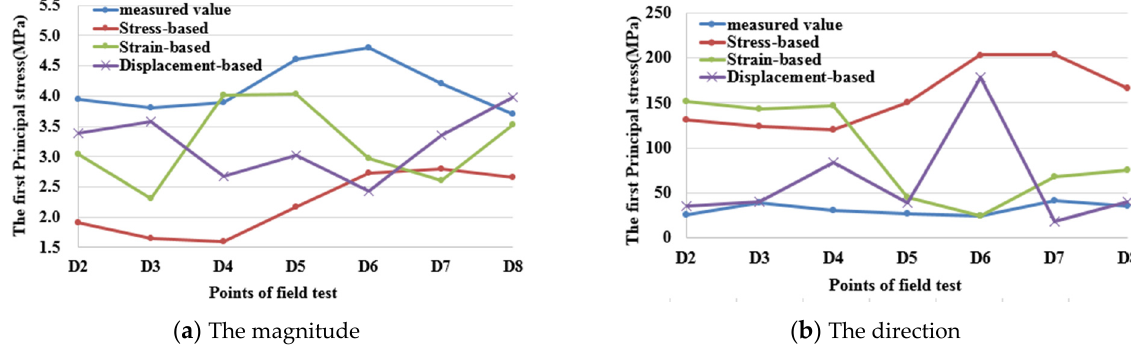
Figure 12. Comparison with measured values of the least principal stress.